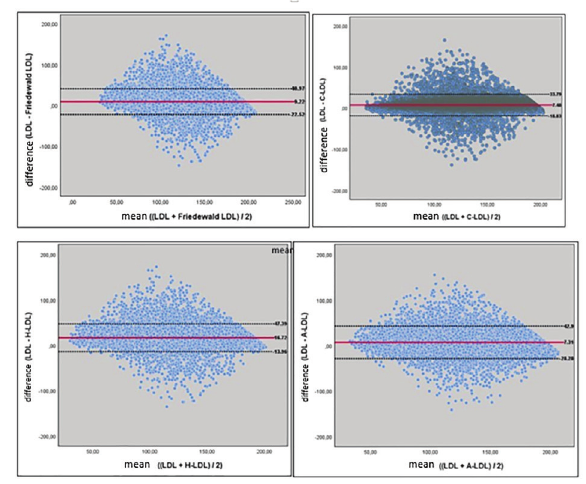
Figure 2 - Bland-Altman plots showing proportional and systemic bias between two sets of measurements. The solid line shows the mean difference between the values while the dotted lines are the upper and the lower limits of agreement (95% observed